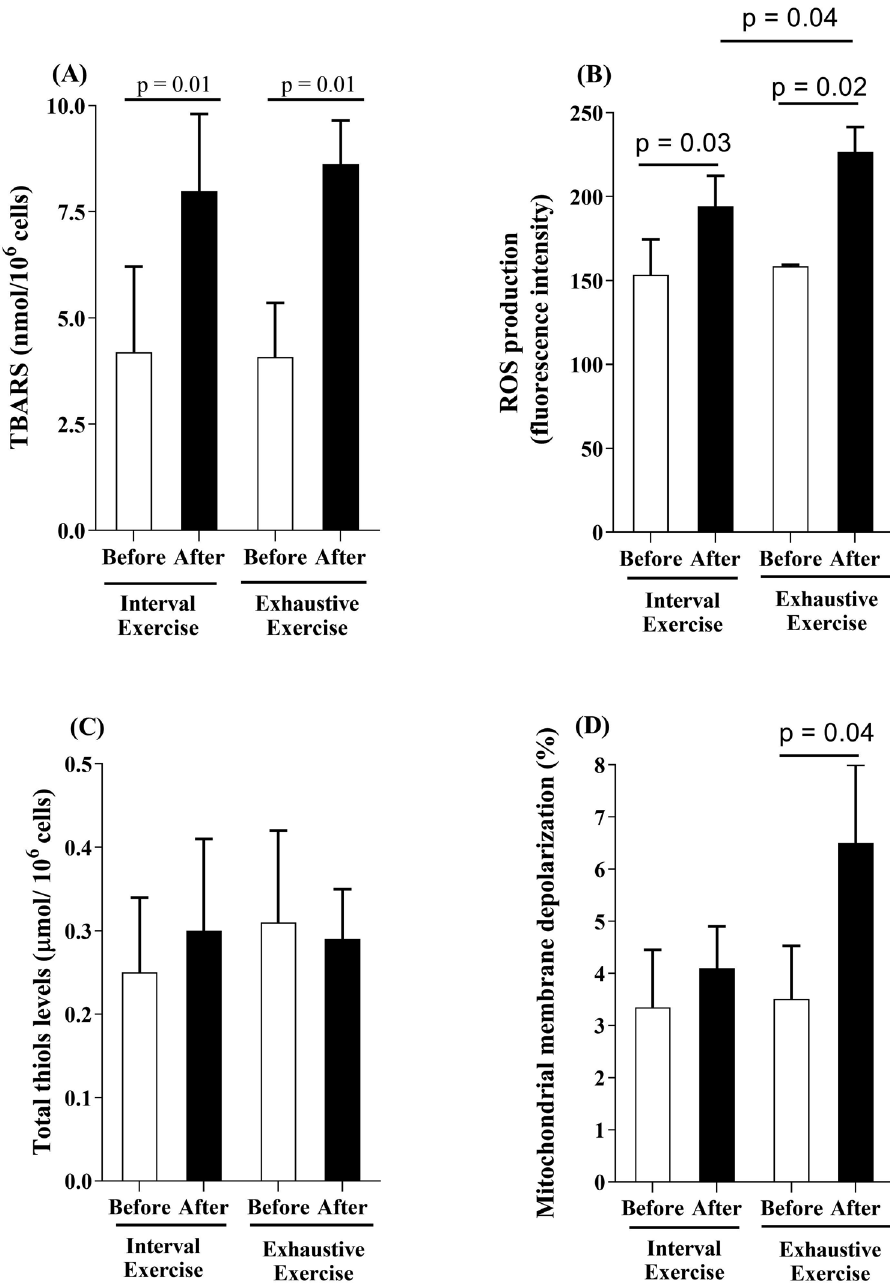
Figure 2. The redox state of mononuclear cells incubated with autologous serum from before (white bars) and after (black bars) two types of exercise. Lipid peroxidation ( A ), ROS production ( B ), total thiols content ( C ), and mitochondrial membrane depolarization ( D ) of PBMC incubated with serum collected before and immediately after high-intensity interval exercise (HIIE) or exhaustive exercise. ( E ) is a representative histogram of mitochondrial membrane potential of PBMC incubated with serum collected before and after each exercise protocol. Statistical analysis conducted by two-way repeated measurements ANOVA with Bonferroni’s post hoc ( p <